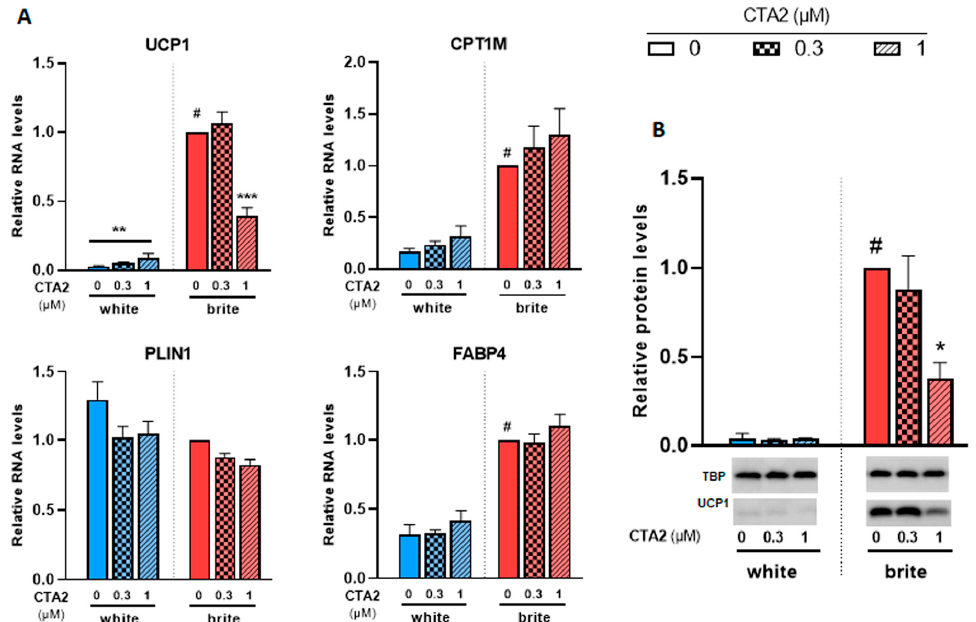
Figure 5. CTA2 inhibits UCP1 expression. White hMADS adipocytes (blue columns) were induced to convert (from day 14 to day 18) into brite adipocytes (red columns) in the presence of various amounts of CTA2 in the absence (white) or the presence of 100 nM rosiglitazone (brite). UCP1, CPT1M, PLIN1 and FABP4 mRNA levels were measured ( A ). 40 µg total protein extracts were analyzed by Western blot ( B ). Histograms display mean ± SEM of three to four ( A ) or two ( B ) independent experiments; statistics were conducted through a two-way ANOVA with Tukey’s multiple comparisons test, where p < 0.05 was considered significant: #: p < 0.05, white vs. brite adipocyte; *: p < 0.05, **: p < 0.01, ***: p < 0.001, treated vs. untreated. We aimed to know whether the TXA2 (CTA2) effects were specific to human cells.